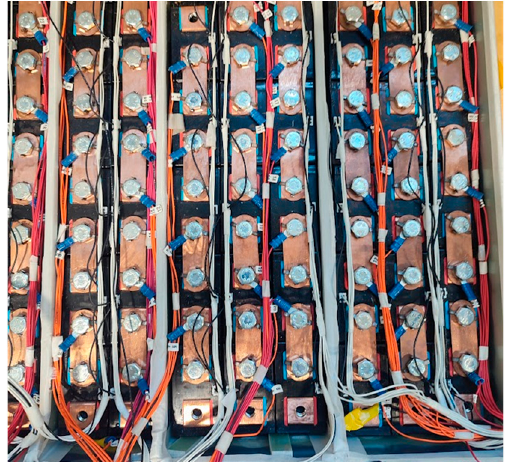
Figure 27. Battery segments.